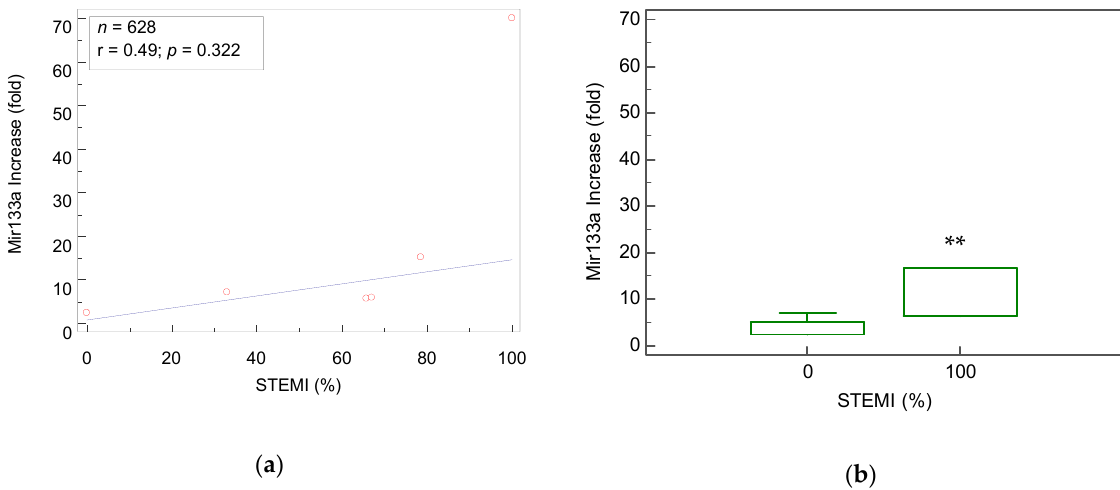
Figure 3. Linear regression analysis of ( a ) a relative increase (in fold) of Mir-133a plotted as a function of the percentage of patients in study with ST elevation myocardial infarction in composite groups. ( b ) Boxplot comparison of fold change in subgroups of 100% STEMI patients vs. 0% STEMI. ** p < 0.001.